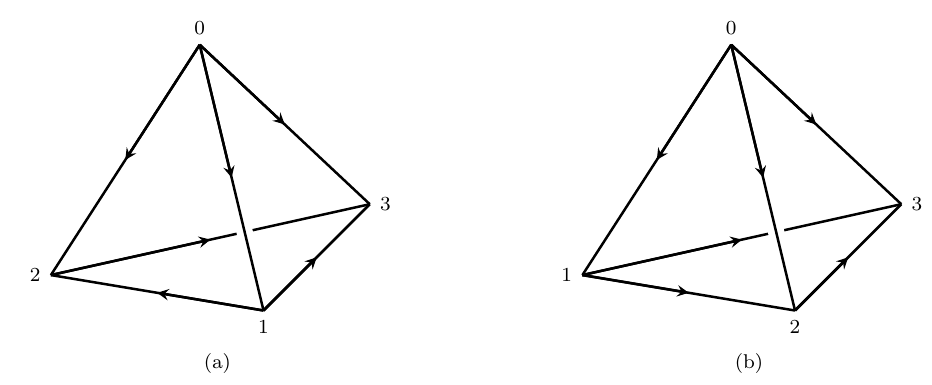
Figure 16 . Given a tetrahedron with a labeling of vertices by i 2 f 0 ; 1 ; 2 ; 3 g , we orient the edges such that vertex with label i has i incoming edges. This de(cid:12)nes a local order on the tetrahedron. Orientation is de(cid:12)ned by using right-hand rule going from 0 to 1 to 2. If the thumb points inward, we say that the tetrahedron is positively oriented as shown in (a). If the thumb points outward, we say that the tetrahedron is negatively oriented as shown in